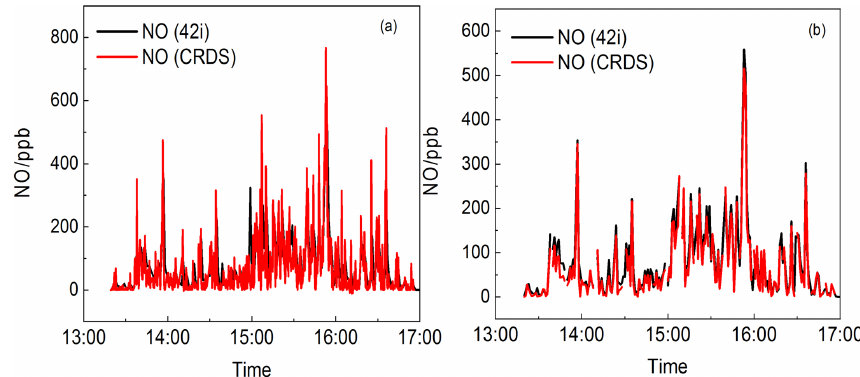
Figure 14. Time series of NO from the CRDS instrument and CL analyser (42i). (a) Data averaged to 5s for the CRDS instrument and (b) the data averaged to